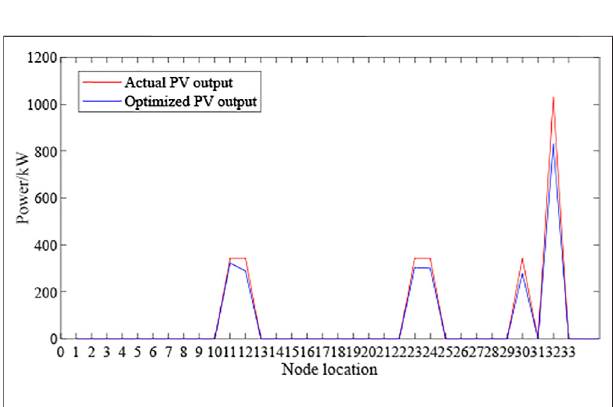
FIGURE 8 | PV outputs under different